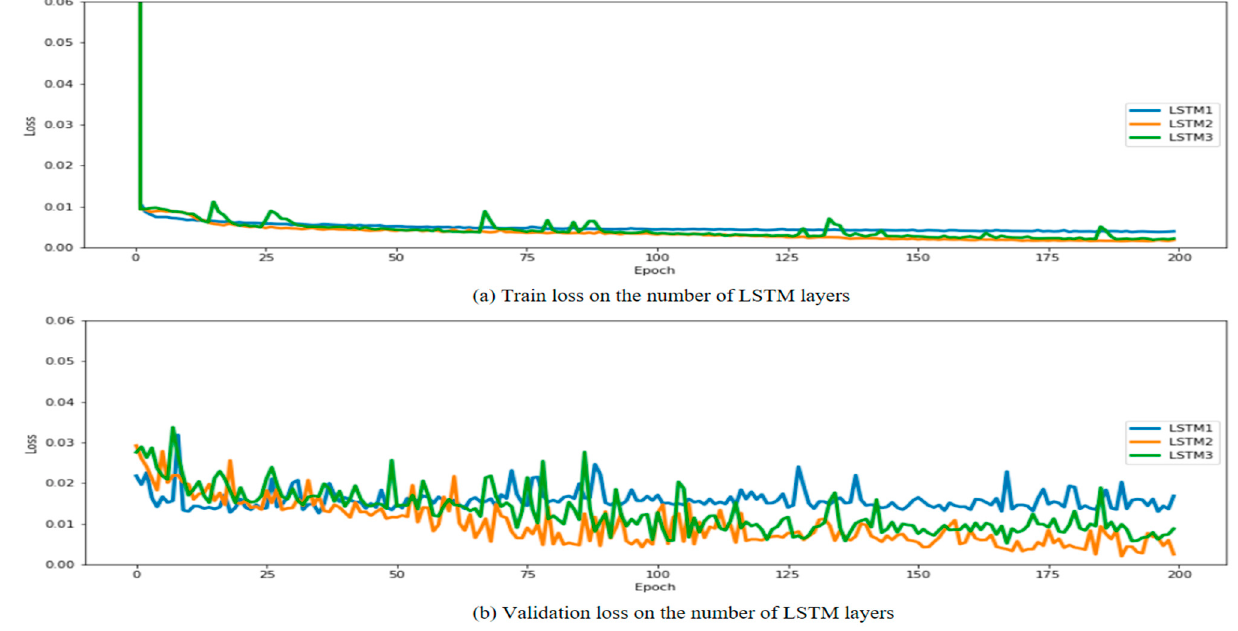
Figure 9. Train and validation loss values according to the number of LSTM layers. ( a ) Train loss on the number of LSTM layers; ( b ) validation loss on the number of LSTM layers.